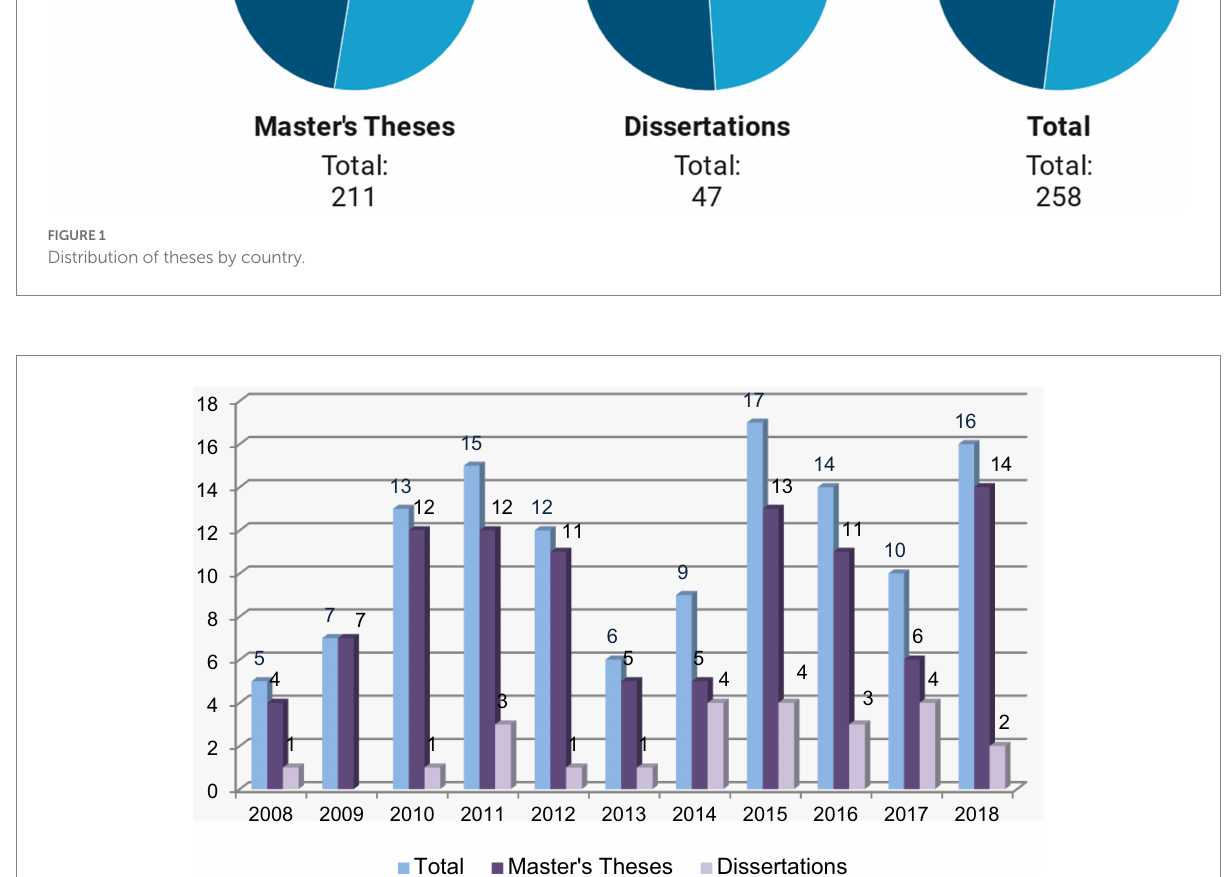
FIGURE 2 Distribution of master’s theses and PhD dissertations of the Austrian sample by